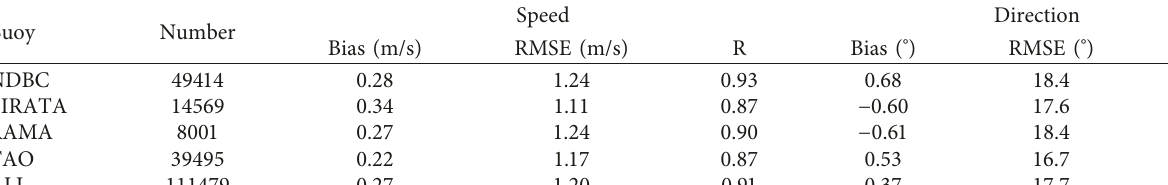
Table 1: Error statistics of the comparison between the OSCAT and buoys wind data.